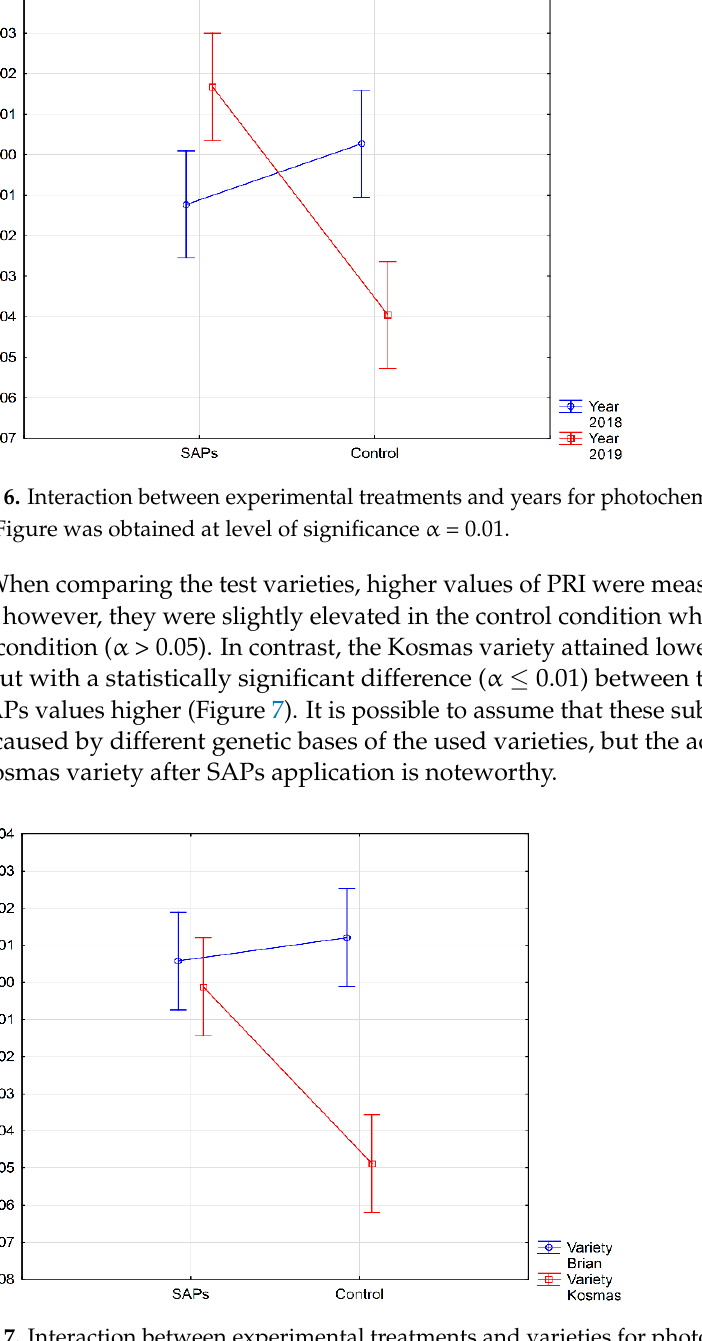
Figure 5. Interaction between experimental treatments and measurements for photochemical re- flectance index (PRI). Figure was obtained at level of significance α = 0.01.